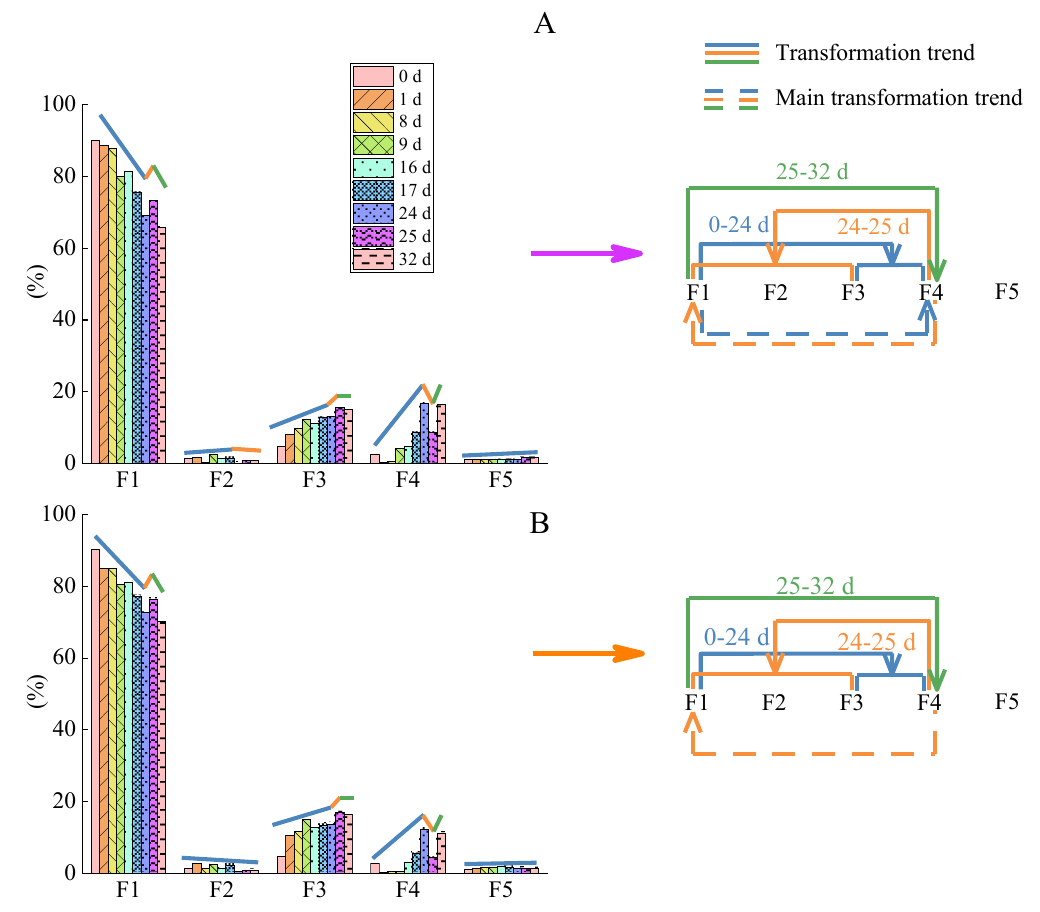
Figure 5. The aging processes of Cd in L T ( A ) and L S ( B ).